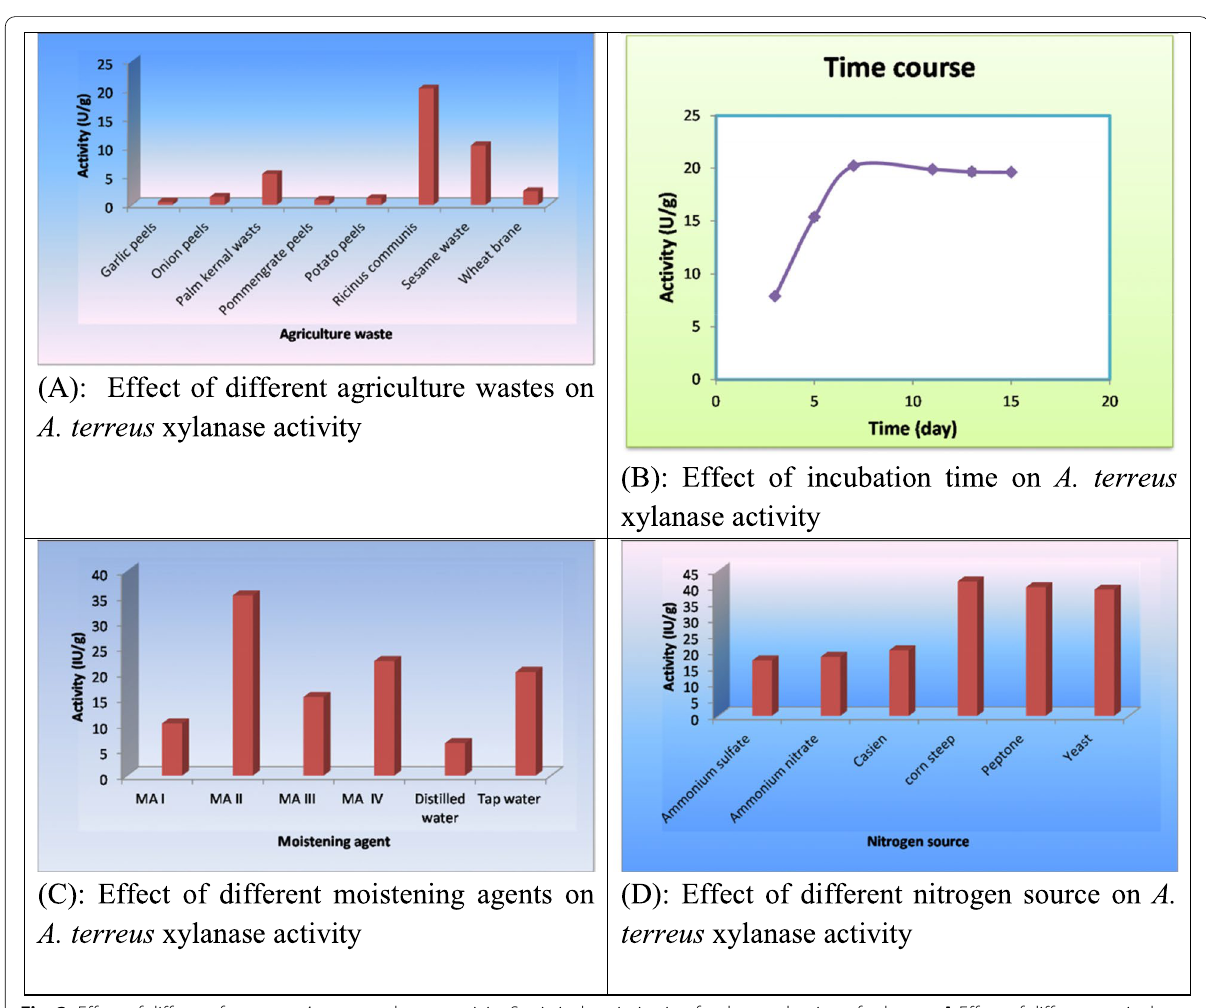
Fig. 3 Effect of different factors on A. terreus xylanase activity Statistical optimization for the production of xylanase. A Effect of different agriculture wastes on A. terreus xylanase activity. B Effect of incubation time on A. terreus xylanase activity. C Effect of different moistening agents on A. terreus xylanase activity. D Effect of different nitrogen source on A. terreus xylanase